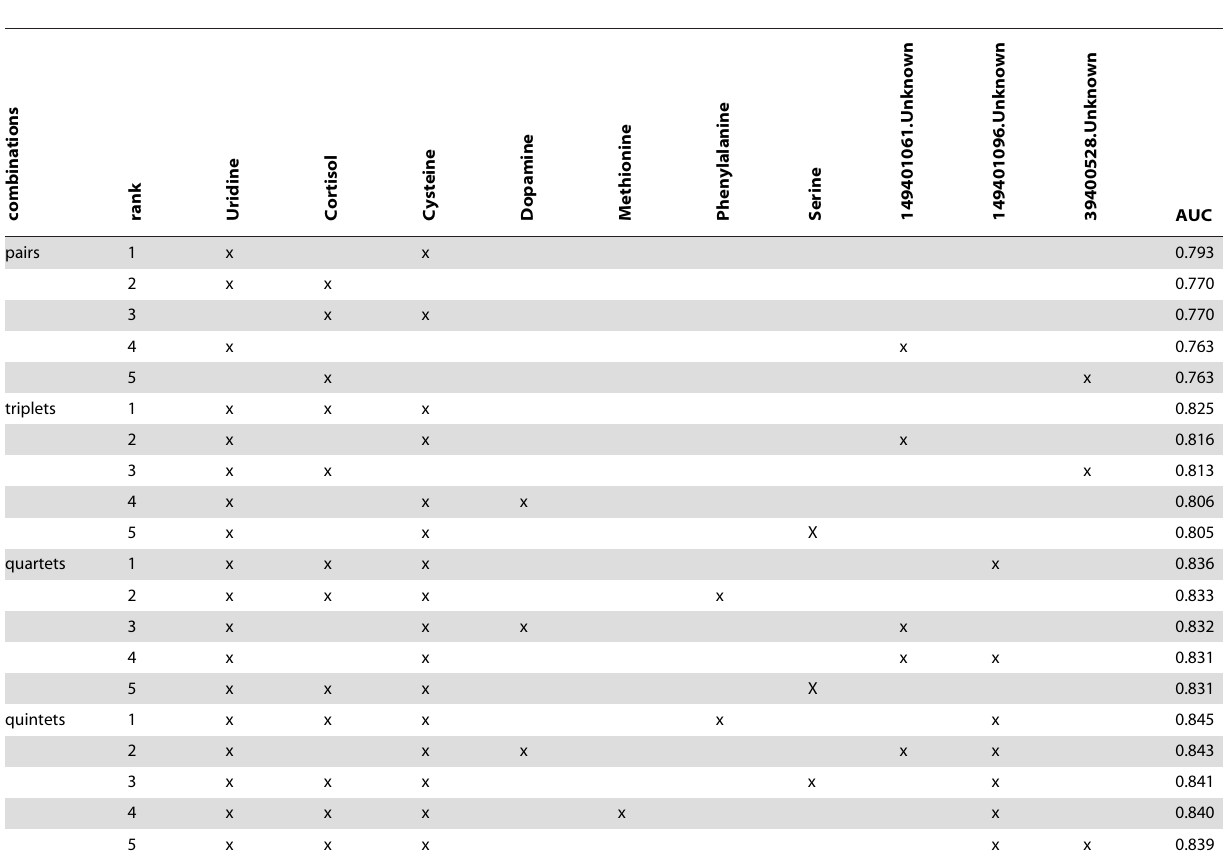
Table 3. Metabolite combinations with highest predictive potentials according to ROC AUC values starting with most promising metabolite combination (‘‘rank’’) for each combination type (pairs, triplets, quartets, quintets). Multivariate classification was based on PLR with combinations of the 16 metabolites selected from and gender- and age-corrected by univariate statistical ANOVA